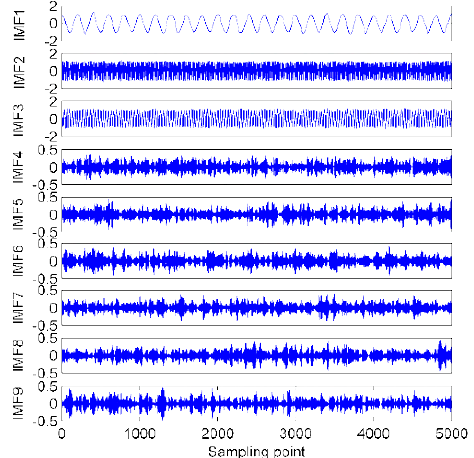
Figure 4. The EVMD decomposition results for the simulated signals.